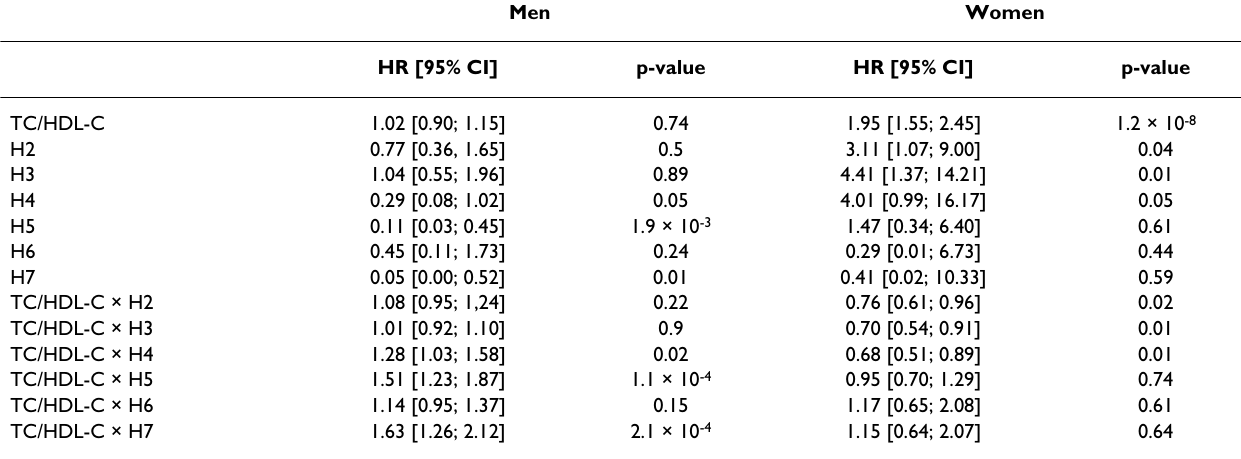
Table 4: Results of haplotype association analysis for type 2 diabetes in interaction effect models (n = 1,968).